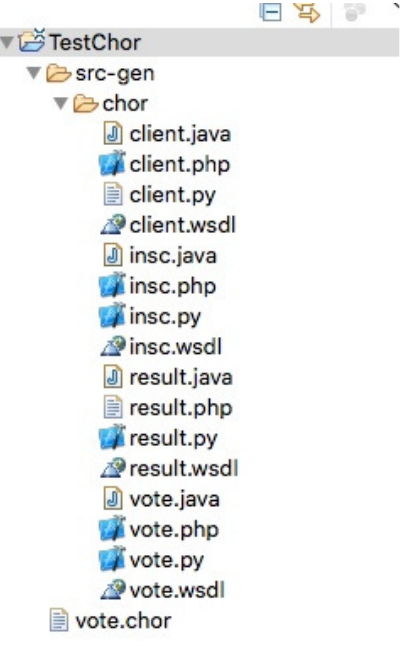
Figure 12. Generated